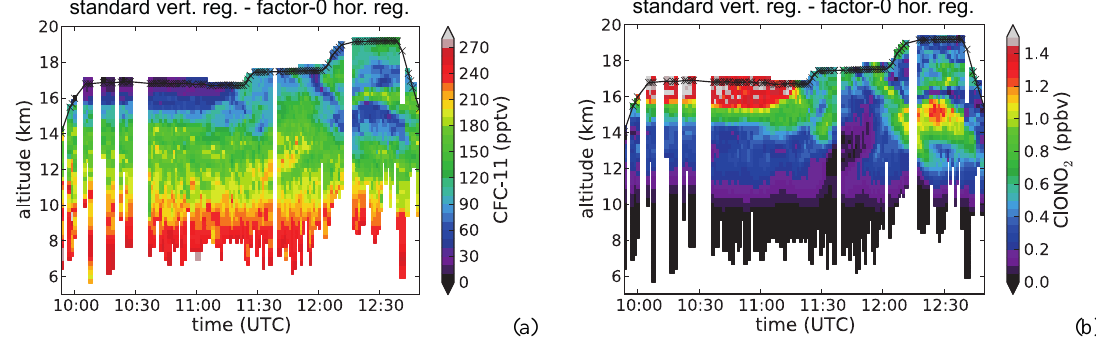
Fig. 2. Two cross-sections of CFC-11 (a) and ClONO 2 (b) volume mixing ratios for the baseline regularisation (standard vertical regularisa- tion and no horizontal regularisation). The straight black line indicates the altitude of the instrument. Crosses on this line indicate the mean position of the instrument during a profile measurement. Table 2. Parameters employed for the regularisation: Tikhonov strength and correlation